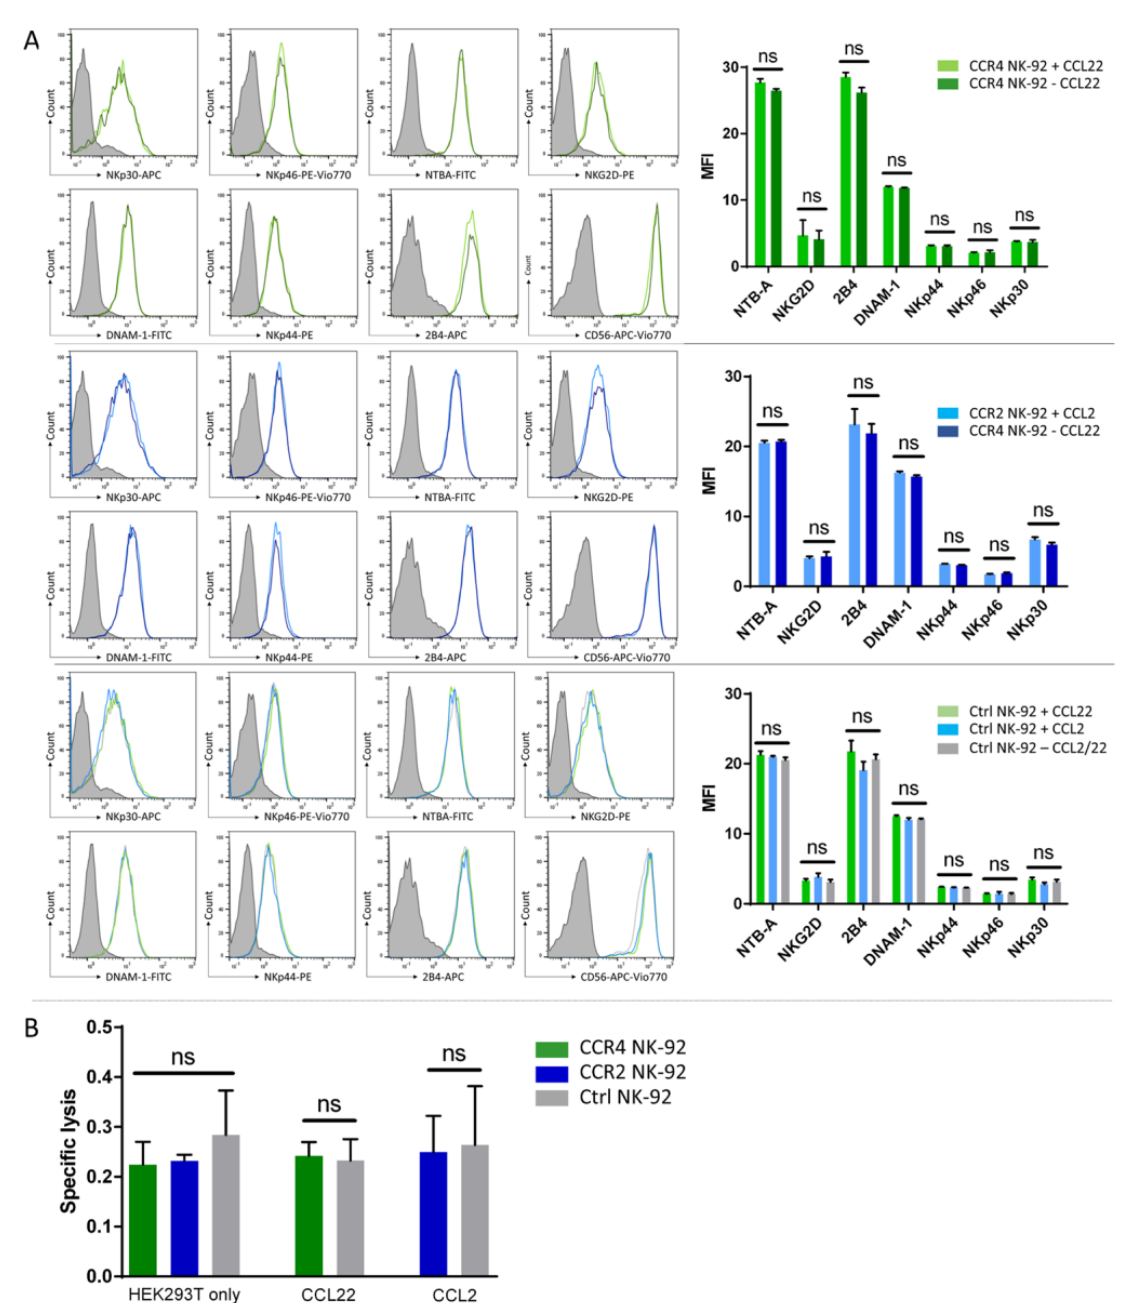
Figure 3. CCR4 or CCR2B expression does not alter the cytotoxic activity of NK-92 cells. ( A ) CCR4- /CCR2-NK-92 and control cells were incubated with the respective ligands (CCL22/CCL2) for 16 h. After that, expression of an array of activating NK cell receptors was analyzed by flow cytometry. Mean MFI values with SD of n = 3 independent experiments are shown. Histogram overlays show the intensity of each receptor’s antibody, the isotype staining is presented as gray shaded histogram. Histograms show one representative out of n = 3 independent experiments. ( B ) NK-92 cells were co-cultured directly with untransduced HEK293T (HEK293T only) and modified HEK293T cells stably overexpressing CCL22 or CCL2 chemokines (CCL22/CCL2). Specific lysis was assessed by flow cytometry. Mean values with SD of n = 3 independent experiments with two technical replicates each are shown for NK-92 cells. Ctrl NK-92: Untransduced NK-92 cells. ns = not significant. Therefore, we concluded that the overexpression of CCR4 and CCR2B selectively changes migratory behavior of NK-92 cells without affecting their ability to lyse tumor cells.